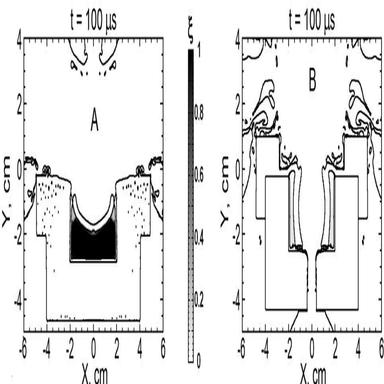
Results of the consolidation modelling (parameter ξ) for the dry road base soil mix, ρ0 = 1.45 g/cm3 .